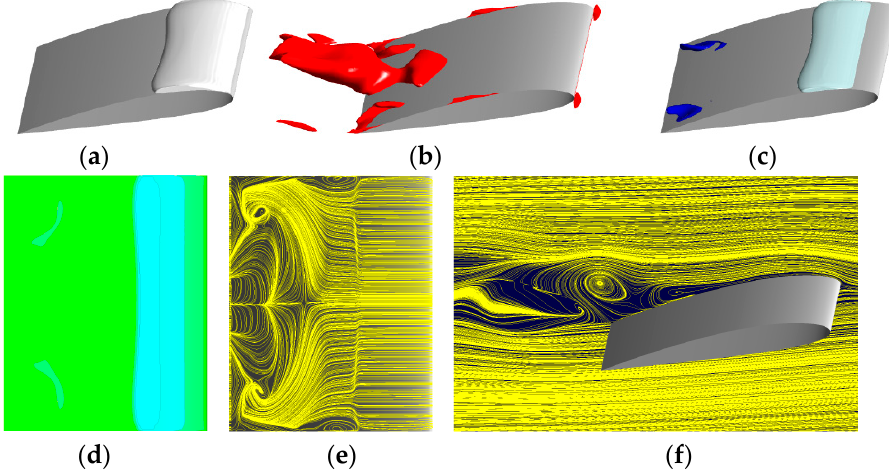
Figure 26. Time instant 6. ( a ) 3D view of cavitation regions (in white); ( b ) back-flow regions (in red); ( c ) evaporation regions (in light cyan) and condensation regions (in dark blue); ( d ) temperature differences on hydrofoil suction side; ( e ) vector lines on hydrofoil suction side; ( f ) vector lines in symmetry plane.